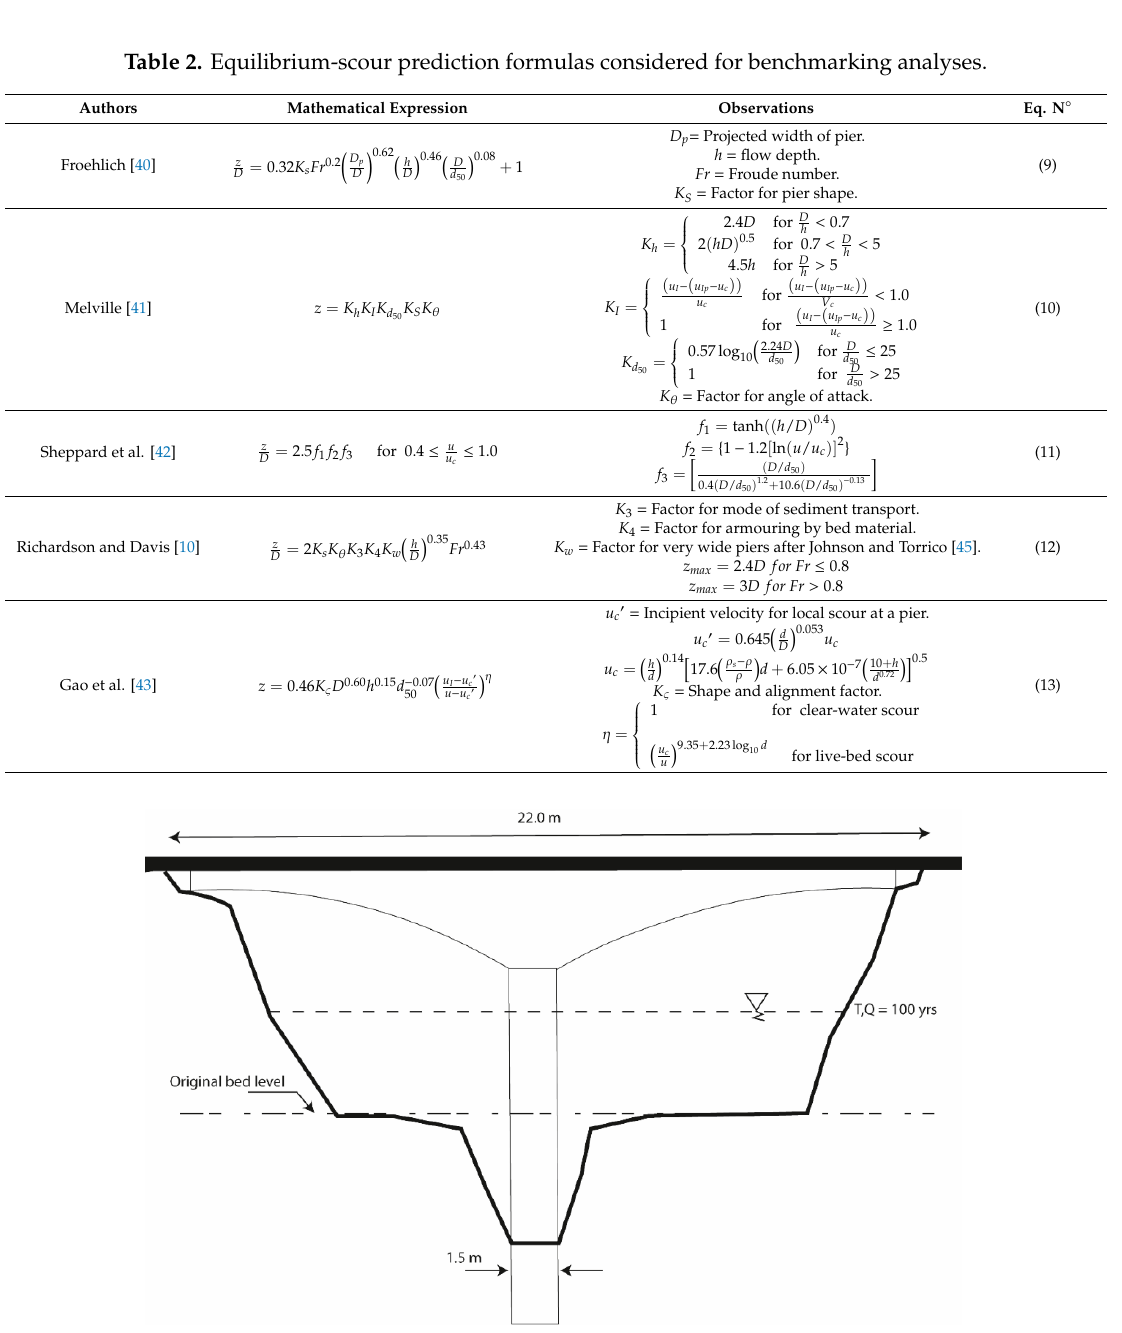
Figure 2. Illustration of the numerical case study considered for scour analyses. Image not to scale. Dashed lines indicate (i) water-level related to a discharge with a return period of 100 years, and (ii) the original bed level.